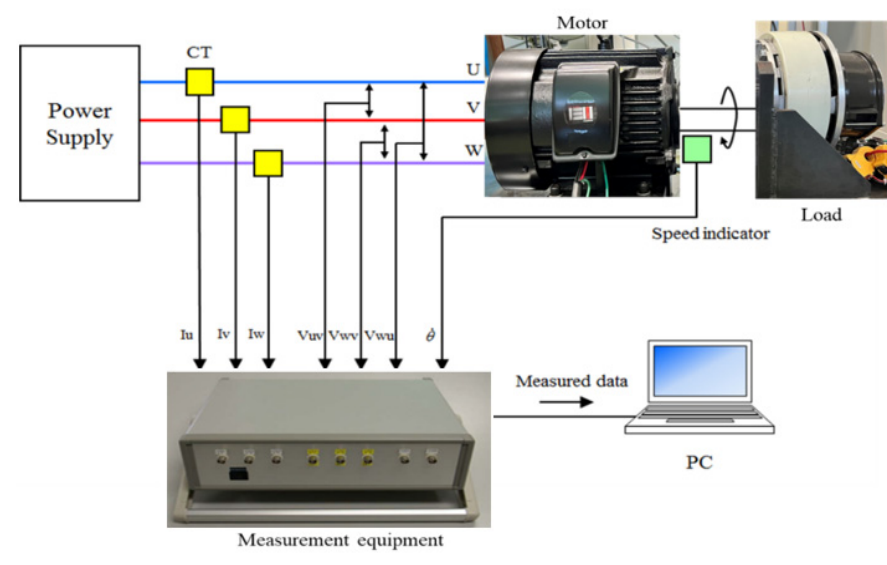
Figure 2. Experimental setup of motor experiment.